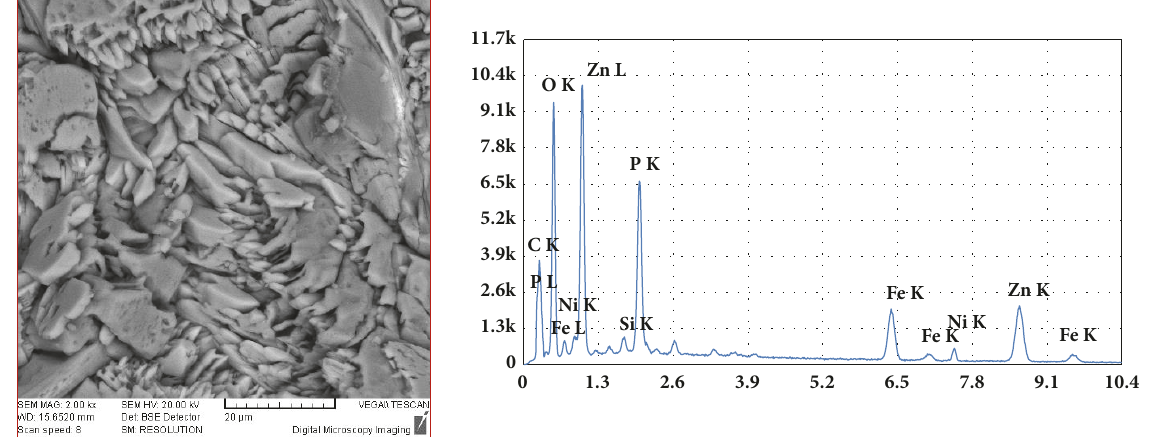
Figure 6: SEM and EDX of ZnP-Ni coating.